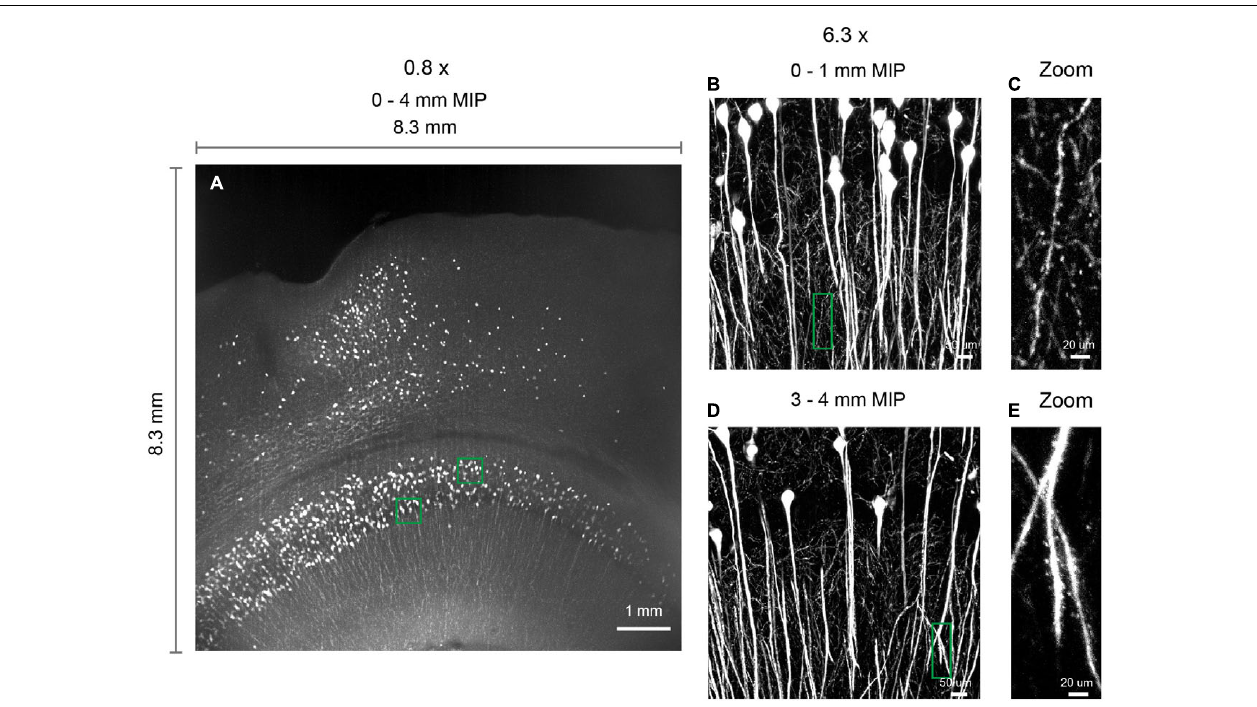
FIGURE 7 | 3D imaging of expanded brain slices at submicron resolution. (A) 3D rendering of a ∼ 8.3 mm × 8.3 mm × 4 mm volume. Thy1-EYFP-H brain slices were expanded by approximately five times using the MAP protocol. Similar results obtained in two independent experiments. (B,D) Zoomed in view of boxed regions in (A) . (C,E) Zoomed in view of boxed regions in (B,D) , demonstrating the ability to visualize